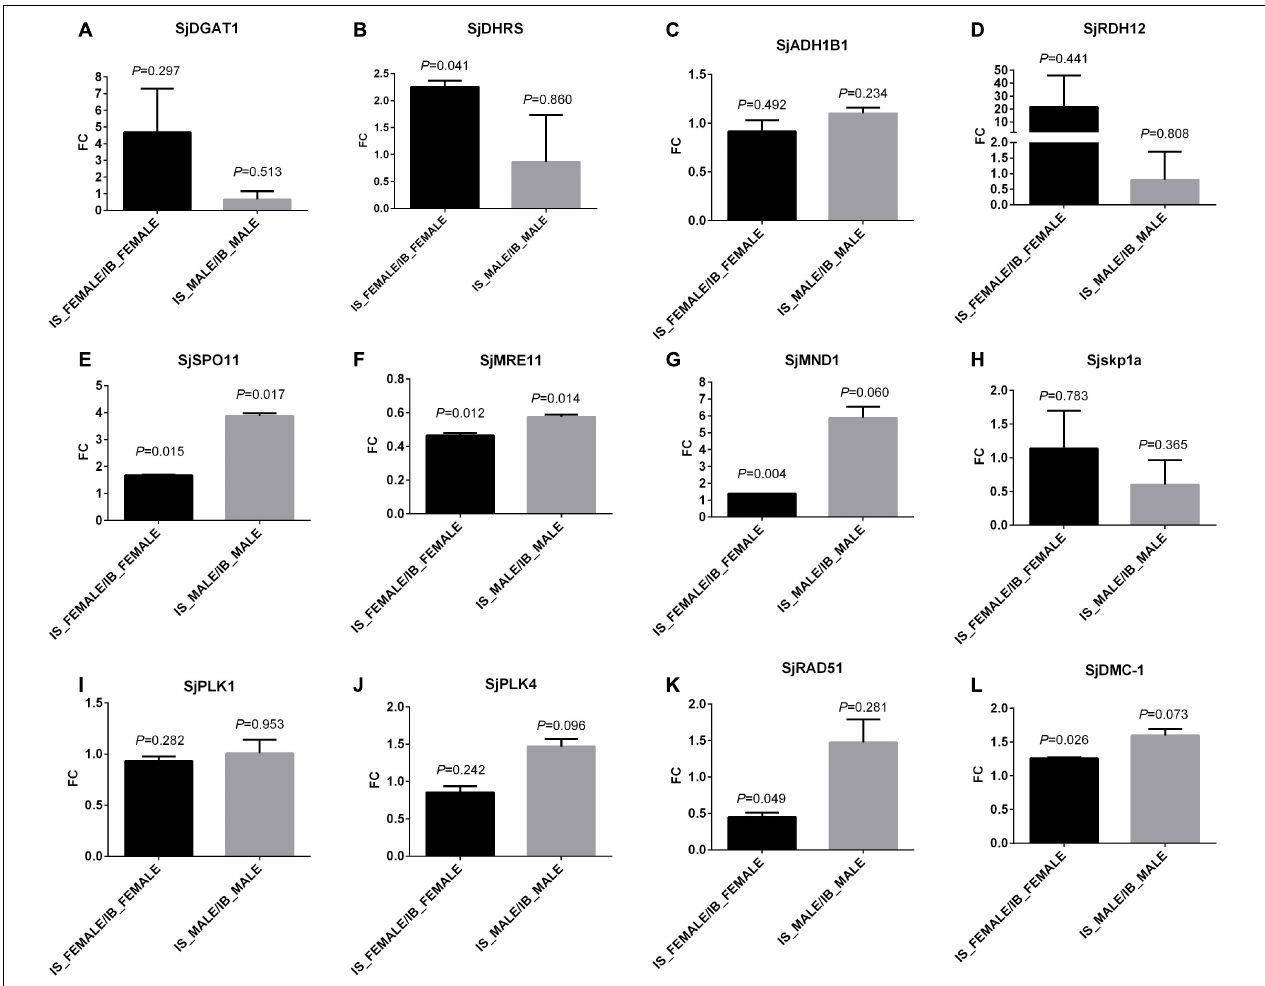
FIGURE 7 | Transcriptional verification of some genes involved in retinol metabolism and the associated meiosis process by qPCR. The tested four genes in “retinol metabolism” are: (A) S. japonicum diacylglycerol O -acyltransferase 1 ( SjDGAT1 ), (B) short chain dehydrogenase/reductase ( SjDHRS ), (C) aldehyde dehydrogenase 1B1 precursor ( SjALDH1B1 ), and (D) retinol dehydrogenase 12 ( SjRDH12 ). The tested eight genes involved in meiosis are: (E) S. japonicum meiotic recombination protein SPO11 ( SjSPO11 ), (F) double-strand break repair protein MRE11A (SjMRE11 ), (G) meiotic nuclear division protein 1-like protein ( SjMND1 ), (H) S-phase kinase-associated protein 1A ( Sjskp1a ), (I) polo-like kinase 1 ( SjPLK1 ), (J) polo-like kinase 4 ( SjPLK4 ), (K) DNA repair protein RAD51 ( SjRAD51 ), and (L) meiotic recombinase DMC1 ( SjDMC1 ). S_F: IS-FEMALE, B_F: IB-FEMALE, S_M: IS-MALE, and B_M: IB-MALE. Two duplicate examinations were performed for each group of worm